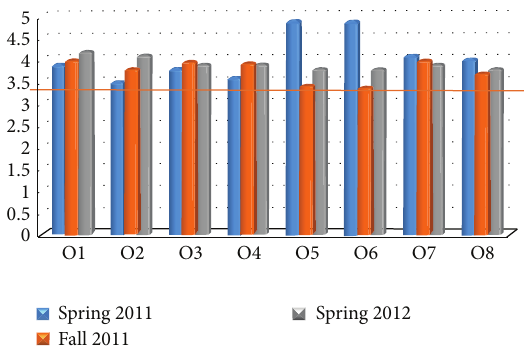
Figure 2: The level of satisfaction of the course outcomes over three semesters for the course MATH1110 (Calculus I for